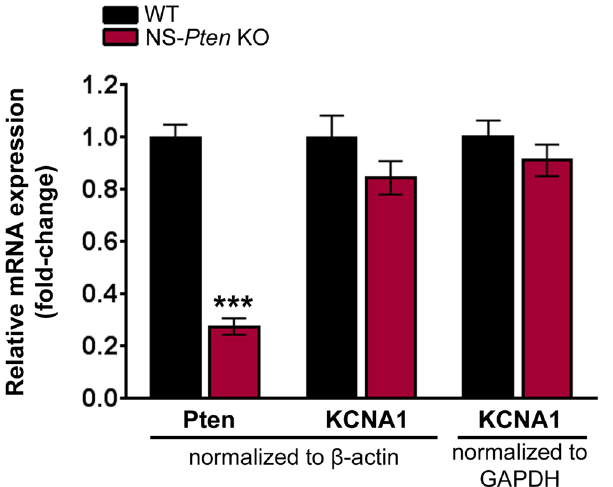
Figure 4. Hippocampal Kv1.1 mRNA (KCNA1) levels are not altered in adult NS- Pten KO mice. Relative quantification of Pten and Kv1.1 (KCNA1) mRNA expression using RT-qPCR analysis on total hippocampal RNA isolated from 8 week-old WT and NS- Pten KO mice are shown. Pten mRNA levels were significantly decreased in NS- Pten KO compared to WT mice. No significant changes in Kv1.1. mRNA levels were observed between NS- Pten KO and WT mice. β -actin and GAPDH expression were used as internal controls. n = 7–8 mice per group; *** p < 0.001 by Student’s t-test; errors bars are ±